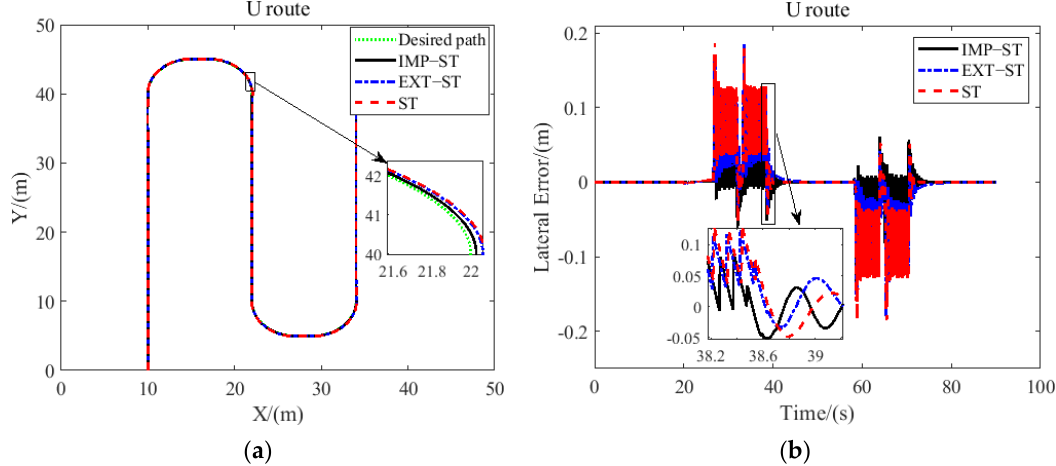
Figure 9. Path tracking performance comparison of three controllers for the U route. ( a ) trajectory; ( b ) lateral error.